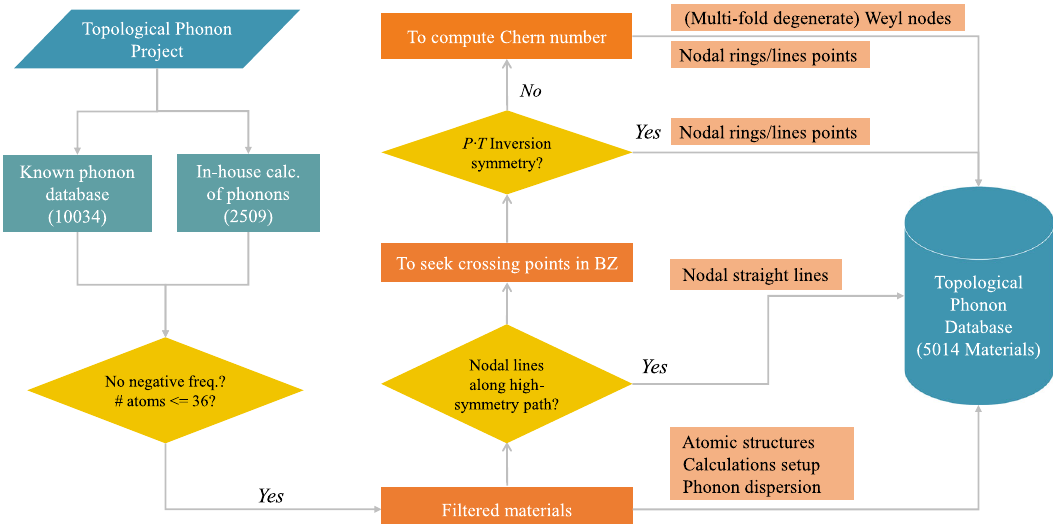
Fig. 1 The schematic fl owchart of high-throughput computational screening on topological phonons. This work fl ow is capable of identifying the features of TPs, elucidating details of topology and constructing TPs database by computing and collecting phonons of a variety of solid materials in an automatic